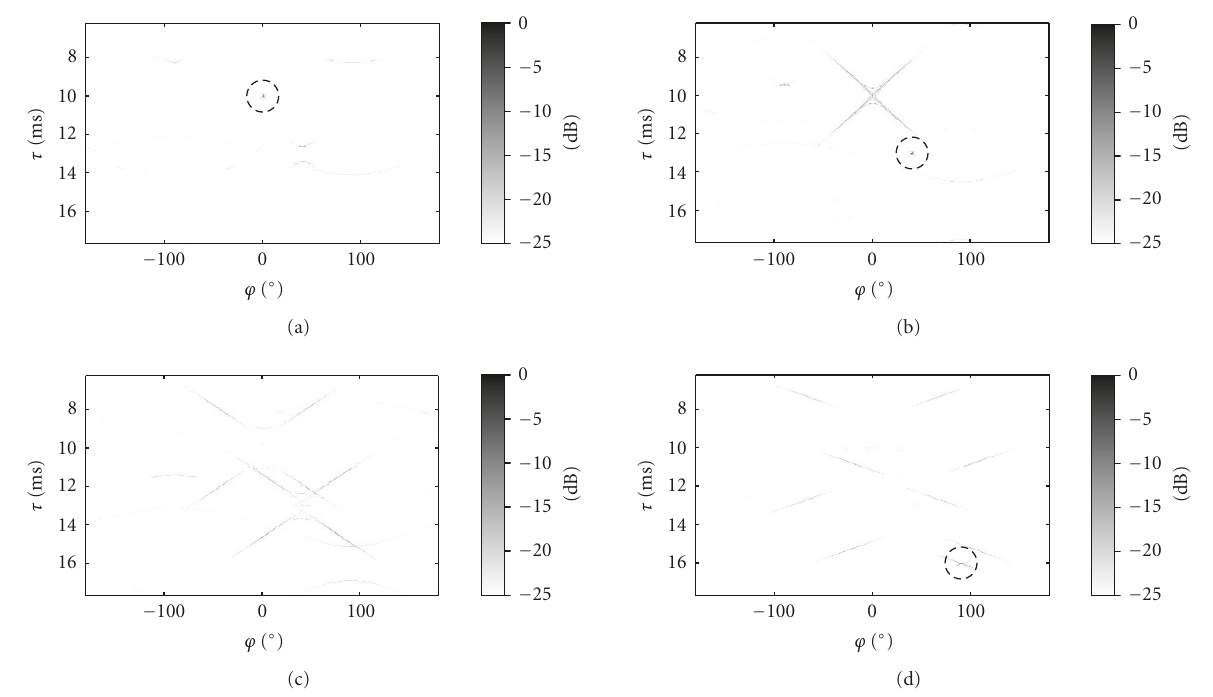
Figure 5: Result of Radon transform application to the simulated data of Figure 3. Model space frames are shown for elevation angles (a) θ = 0 ◦ , (b) 30 ◦ , (c) 50 ◦ , and (d) 70 ◦ . The representations of the three waves in the data set are marked with circles in the corresponding elevation angle frames.